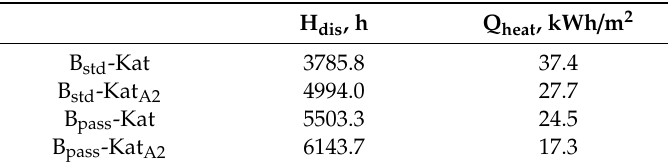
Table 3. Results for the solution with the greater H dis .